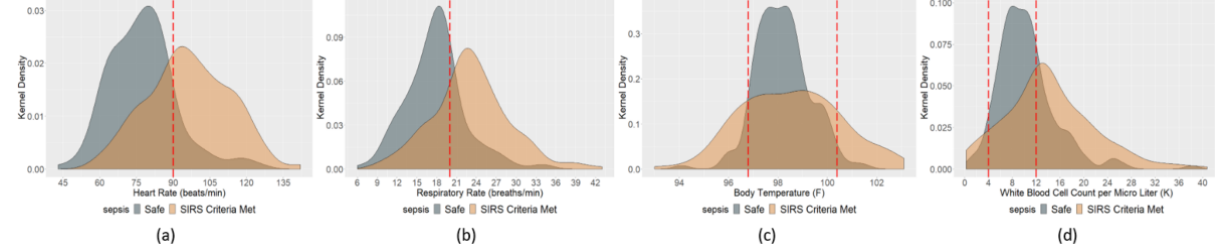
Figure 9. Kernel density estimation distribution of systemic inflammatory response syndrome (SIRS) parameters for both safe and sepsis criterion–met patients at first observations to identify the prevalent SIRS parameters.